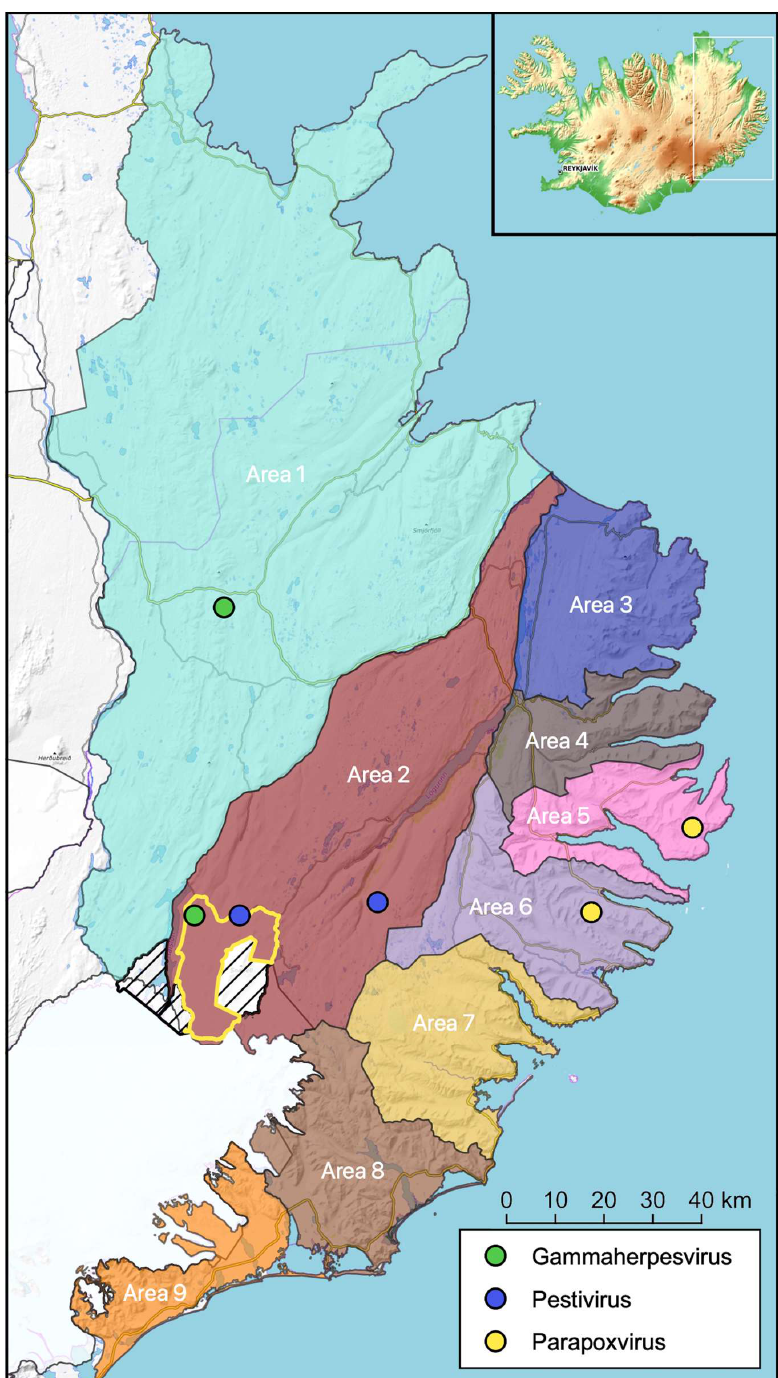
Figure 2. Icelandic wild Eurasian tundra reindeer ( n = 281), all being descendants from 35 animals imported from Norway in 1787, were sampled and tested for exposure to potential reindeer viral pathogens. Two reindeer with anti-pestivirus antibodies are indicated with blue dots (Area 2), two reindeer with antibodies against gammaherpesvirus (MCFV-group) are indicated with green dots (Area 1 and 2) and two reindeer shedding parapoxvirus on their nasal mucosal membrane are indicated with yellow dots (Area 5 and 6). All animals were seronegative for alphaherpesvirus, bluetongue virus, and Schmallenberg virus. The yellow line in Area 2 indicates the national park and the two shaded areas indicate protected areas around the Snæfell mountain.